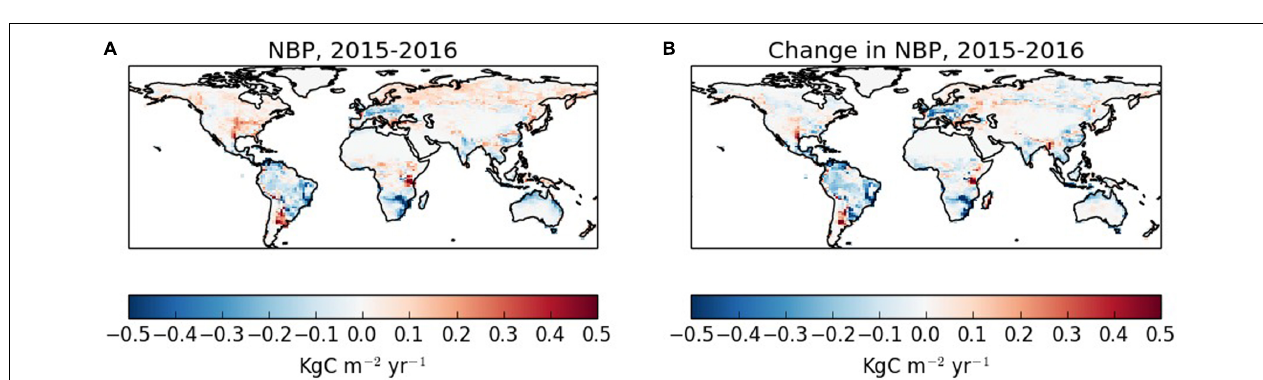
FIGURE 8 | Drivers of burned area globally (A) and for South America (B) from January 2015–June 2016 simulated by JULES-INFERNO.